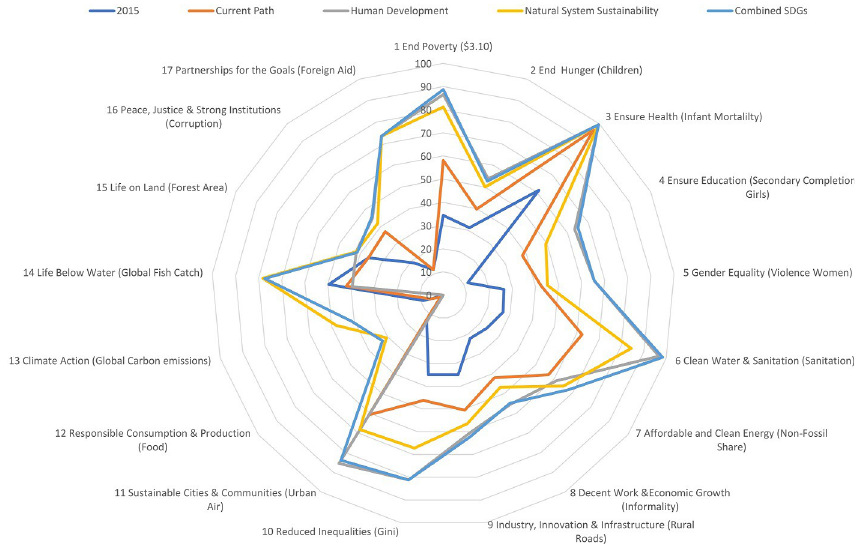
Fig 6. Analysis of progress toward SDG targets on current path and with three sets of interventions. Note: Values are the percentage of countries reaching the identified target in 2015 or 2050 scenarios, except fisheries and carbon where they are extent of progress toward a global goal. Source: Hughes [55]; IFs Version 7.45.